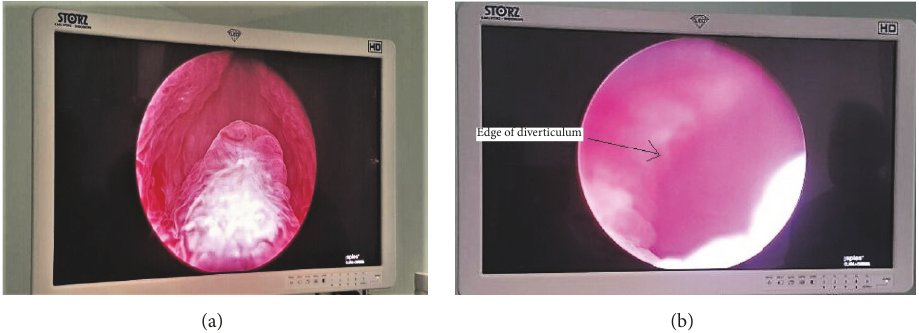
Figure 2: (a) Open prostatic fossa; (b) bladder